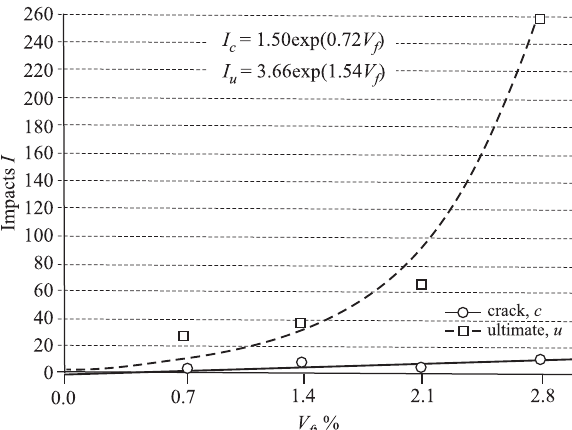
Fig. 6. Number of impacts to first observed crack and to ultimate destruction